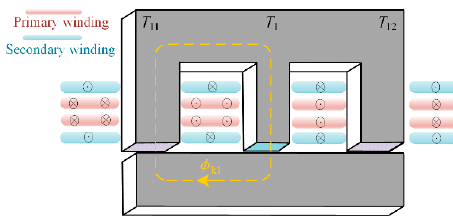
Figure 8. Integration scheme of T 1 .